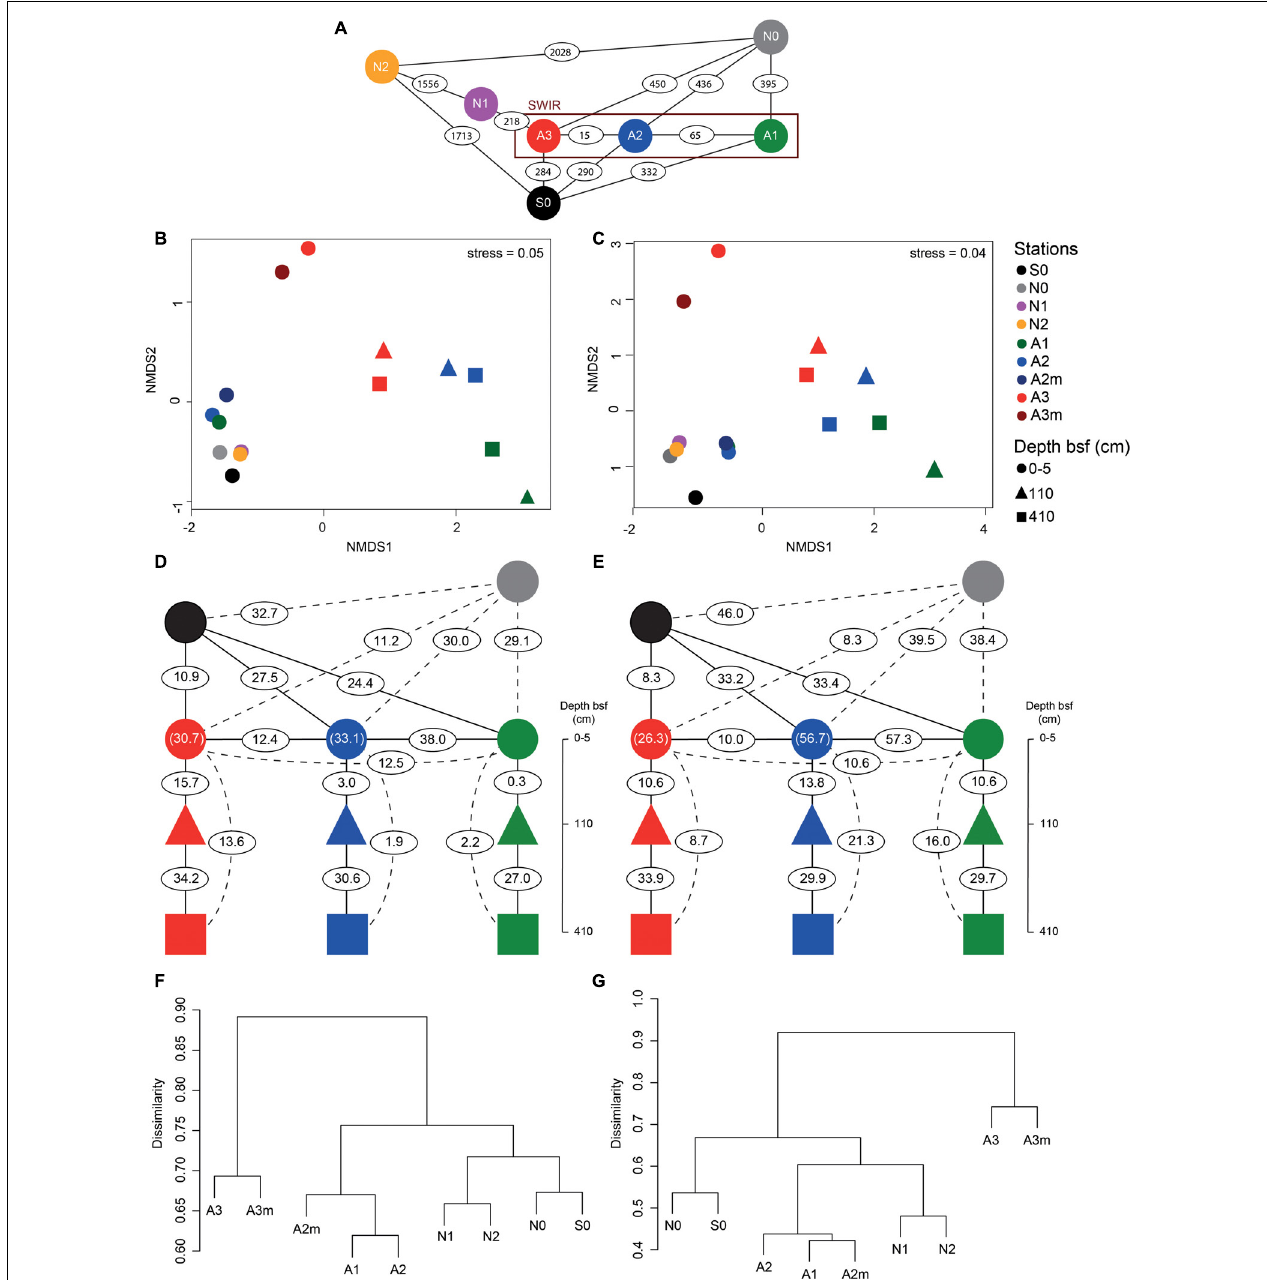
FIGURE 5 | Beta-diversity of bacterial and archaeal communities in surface and subsurface sediments. (A) Geographic distance in kilometers between the investigated stations. Non-metric multidimensional scaling (nMDS) using Bray–Curtis distance on Hellinger transformed (B) bacterial and (C) archaeal community structure at OTU level. Percentage of (D–F) bacterial and (E–G) archaeal shared OTU between stations as defined by Jaccard dissimilarity matrix based on presence/absence OTU table (with 100 sequence re-samplings per sample on the smallest dataset); the numbers in parentheses represent the shared OTU between A2/A2m (green blue) and A3/A3m (red circle). For full matrices see Supplementary Table S3 . bsf, below the